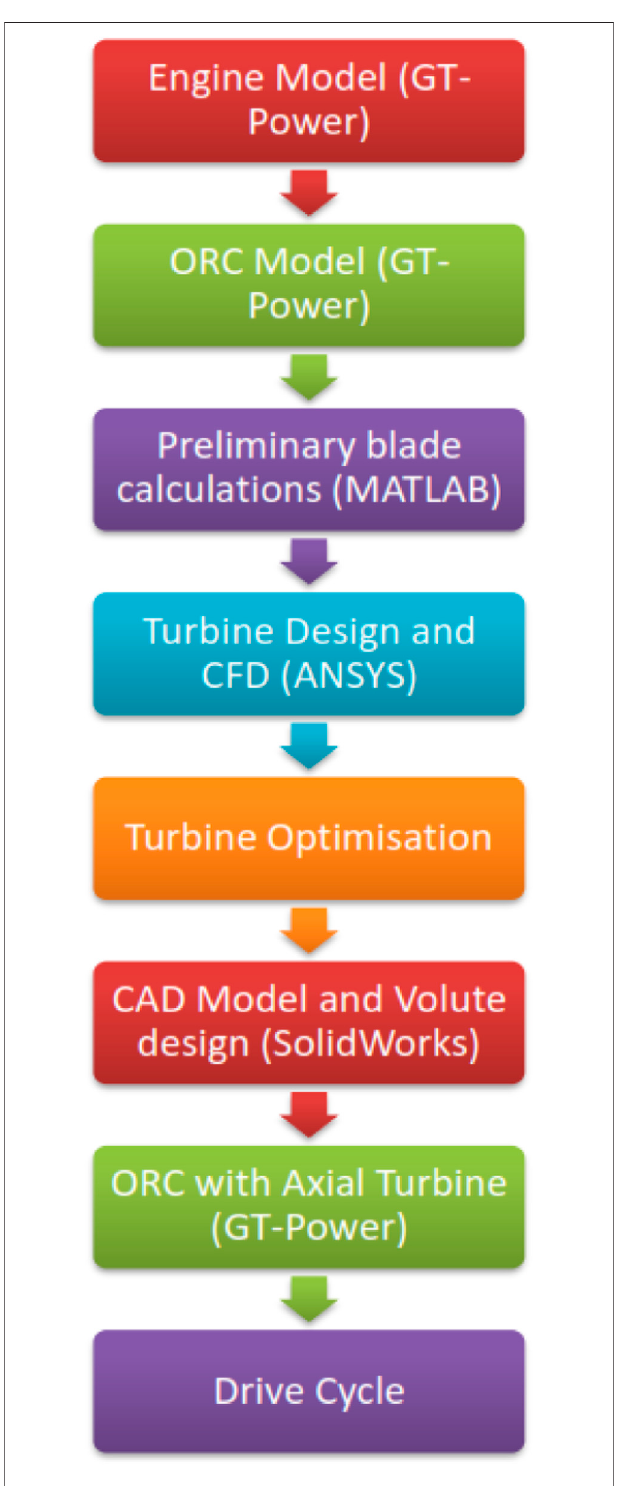
FIGURE 4 | Methodology applied in this